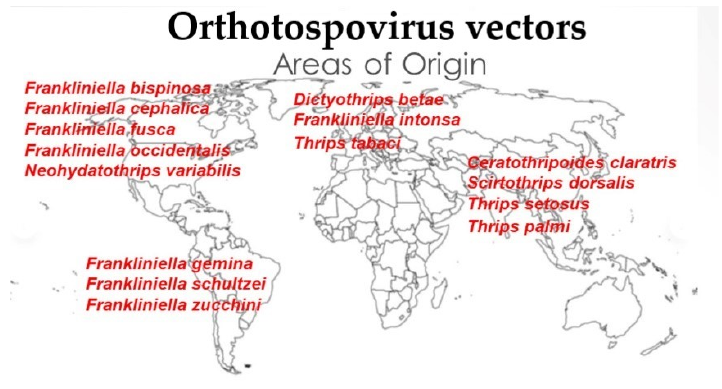
Figure 2. Geographical origins of Orthotospovirus vector species.